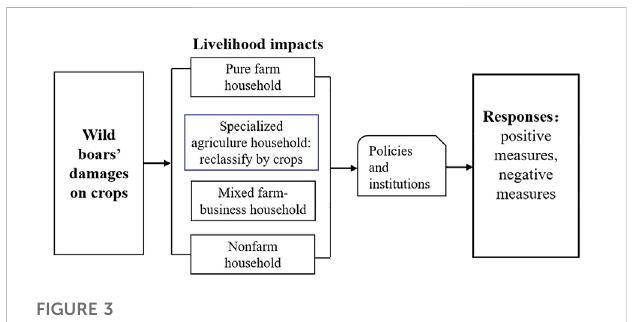
FIGURE 3 Livelihood impacts and farmers ’ responses to human-wild boar con fl icts.